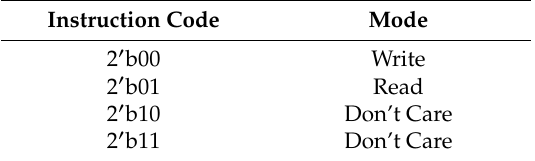
Figure 7. The low-power synchronous preamble data line protocol architecture. Table 2. The low-power synchronous preamble data line protocol instruction